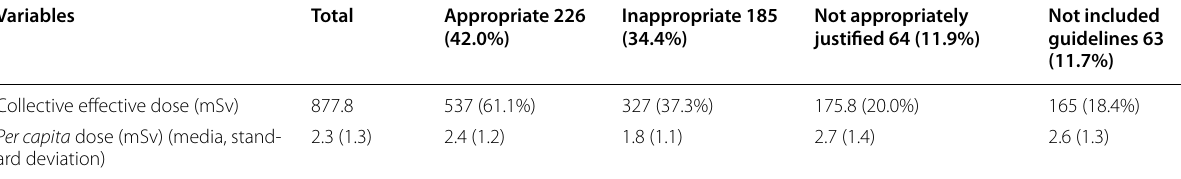
Table 3 Collective and per capita effective dose according to imaging test appropriateness